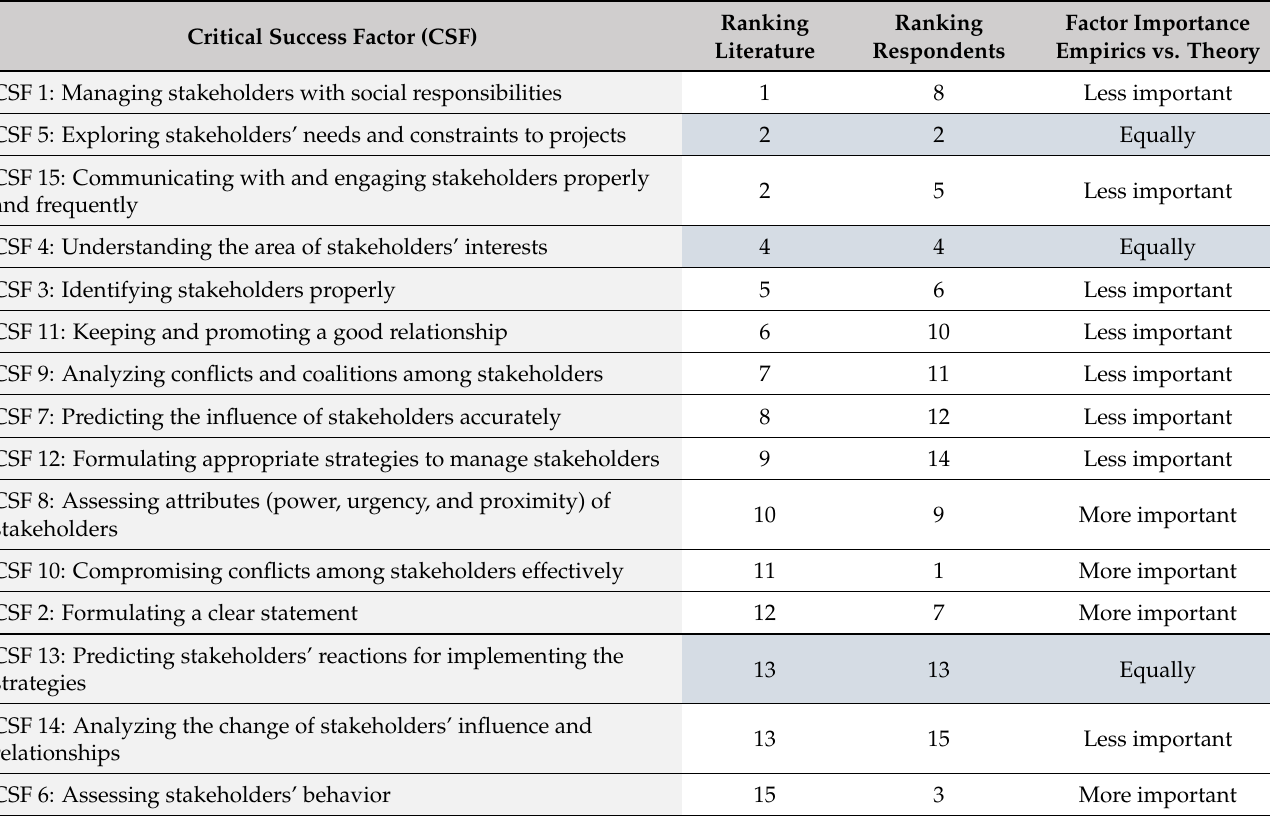
Table 11. Comparing the critical success factors adapted from Yang et al. (2010) with the responses retrieved in the